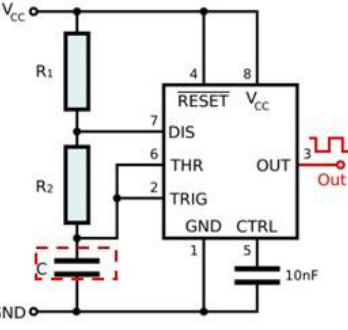
Figure 4. TreeTalker oscillator circuit using 555 Timer.